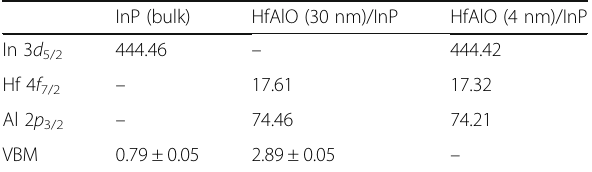
Table 1 Binding energies (in eV) of core level spectra for all the samples and the valence band maximum (VBM) values (in eV) for the bulk InP and HfAlO (30 nm)/InP